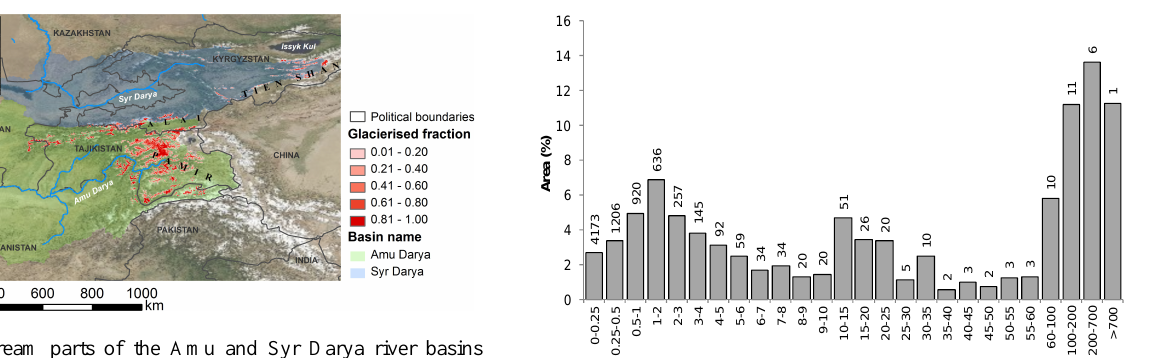
Fig. 1. Upstream parts of the Amu and Syr Darya river basins (in green and pale blue, respectively), the main river system (blue lines), the initial glacierized fraction per 1km grid cell (red shades) and political boundaries (black lines).